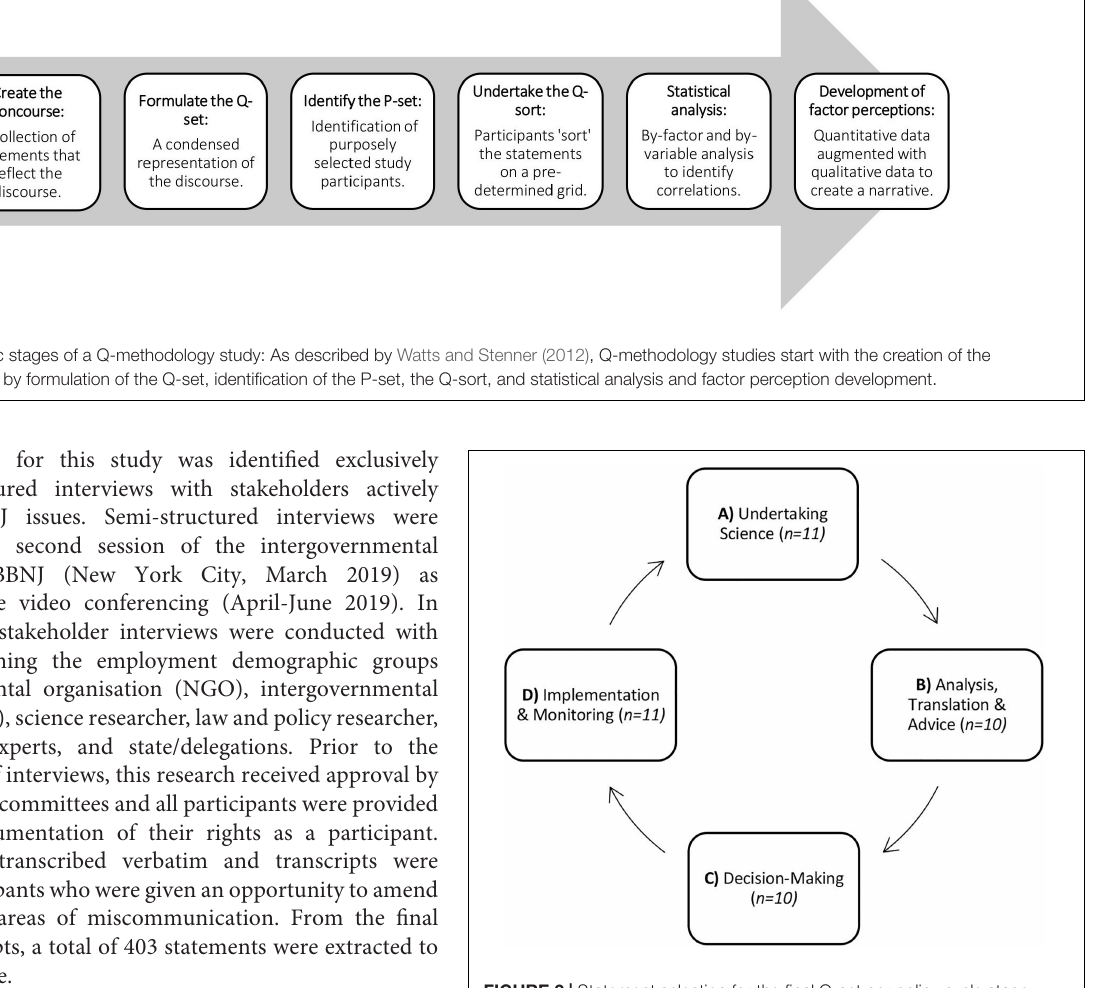
FIGURE 2 | Statement selection for the final Q-set per policy cycle stage: Division of statements under the concourse matrix ( n =statements). The basic policy cycle depicts a policy process under which scientific evidence is undertaken (A) , analysed and translated into usable metrics and presented to policymakers (B) for use in decision-making (C) and is ultimately reflected in the implementation and monitoring of management measures (D)